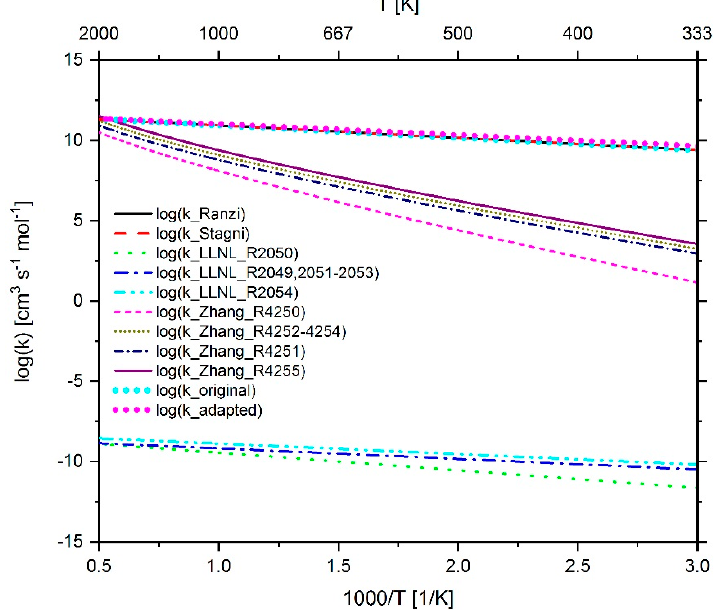
Figure 25. Comparison of the reaction rate coefficient of reaction 296 ( n -C 7 H 15 + O 2 ↔ C 7 H 14 + HO 2 ) before and after adaptation as well as the rate coefficients used in the mechanism of Ranzi et al. [116], Stagni et al. [119], LLNL [23] and Zhang et. al . [21].